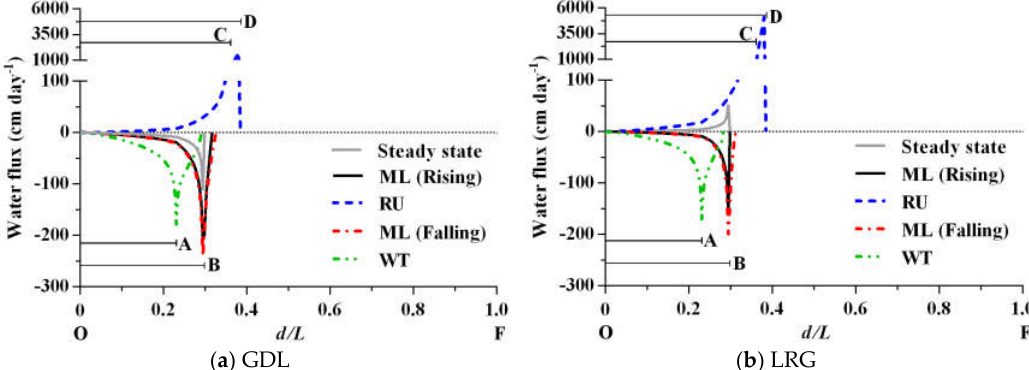
Figure 5. Distributions of water fluxes along the lake–groundwater interface (OF) for no-wave conditions and at different stages of a wave cycle for the GDL ( a ) and LRG ( b ) cases. (ML, RU, and WT represent the mean lake level (38.5 cm), the run-up height (50 cm), and the wave trough (30 cm), respectively; positive fluxes are into the subsurface zone and negative fluxes into the lake). See Figure 1 for locations of points A, B, C, D, F, and O. Horizontal solid lines represent relative distances of points A, B, C, and D from point O. The gray horizontal line represents zero water flux. Notice the break in the vertical axis.